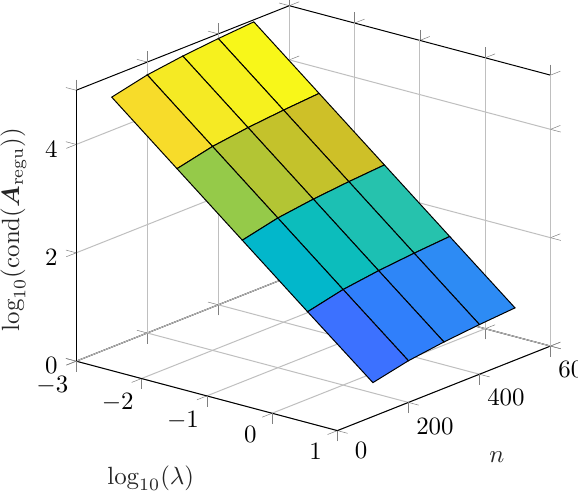
Figure 5. Condition number of the regularized matrix A for 100 to 500 time constants between 10mHz and 10kHz and λ from Figure 3. Condition number for non-regularized matrix between 1.1 and 8.2 10 19 ×